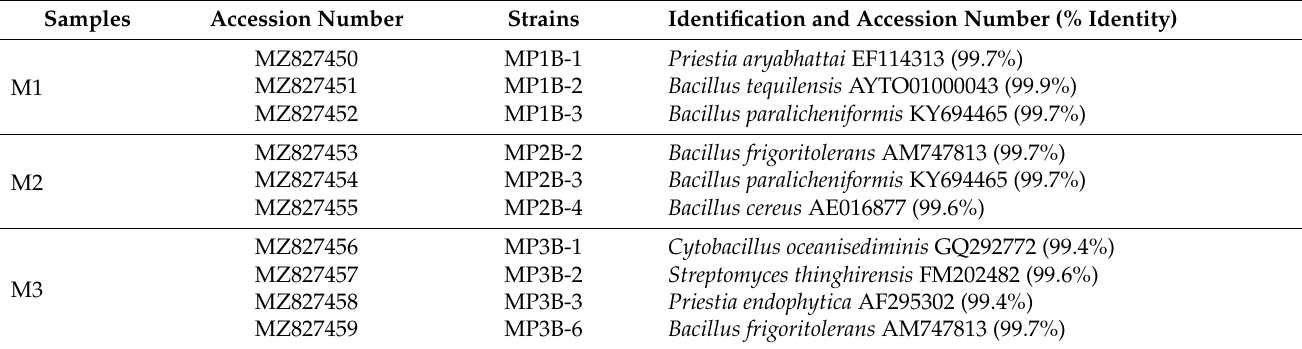
Table 3. Identification of bacteria isolated from Sal ó n de Reinos .